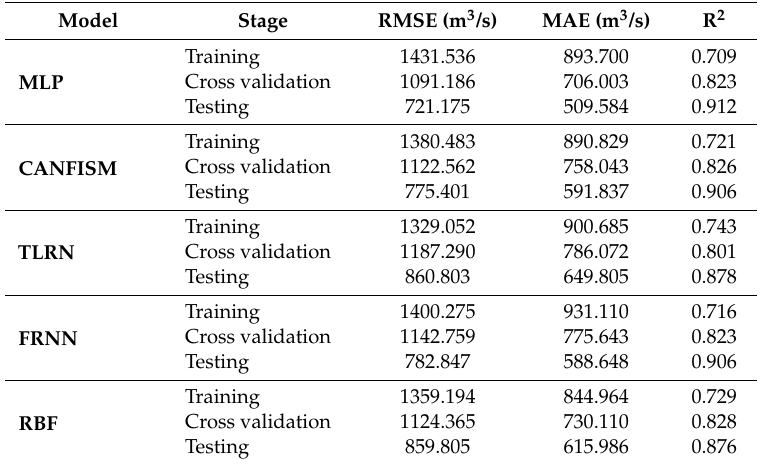
Table 5. Summary of model statistical performance.